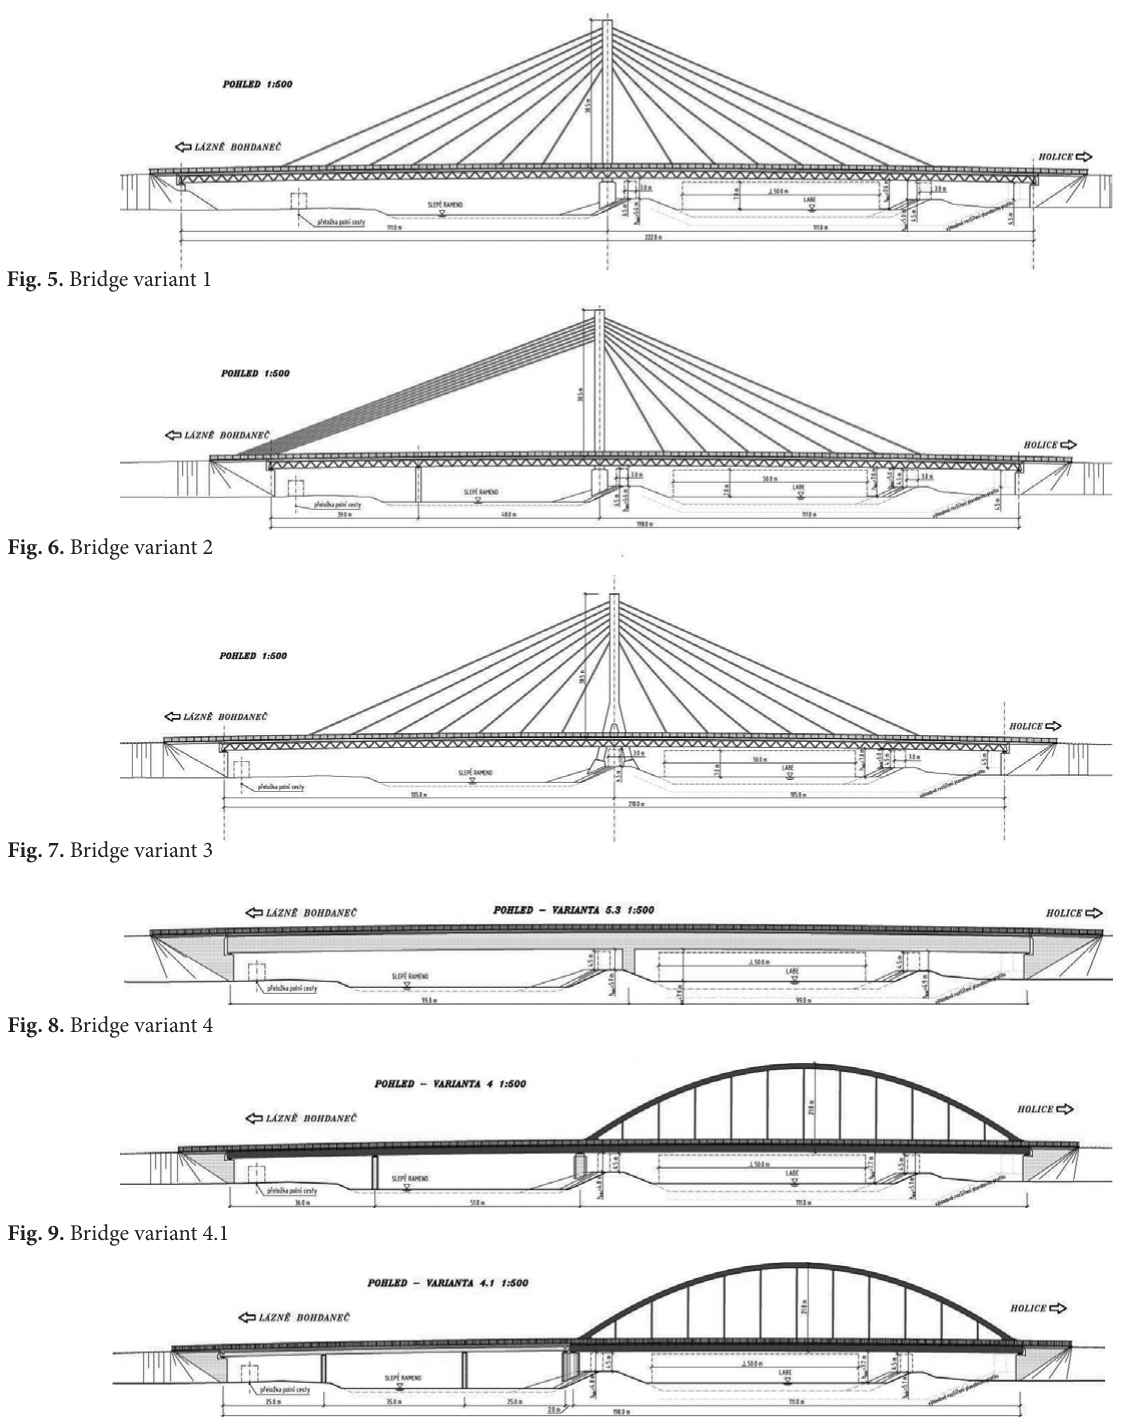
Fig. 10. Bridge variant